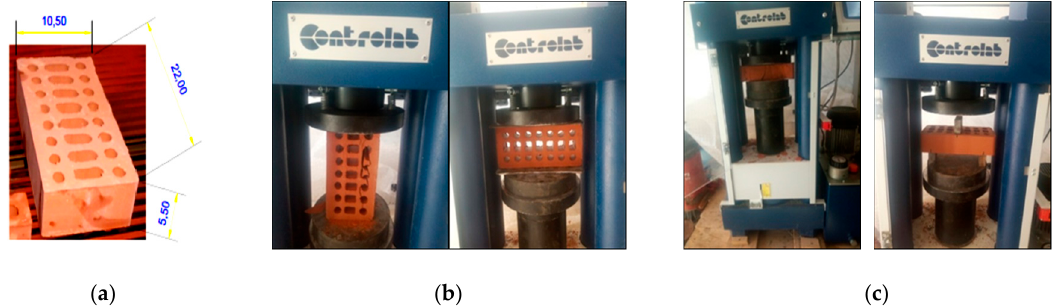
Figure 1. ( a ) Brick units; ( b ) compression test; ( c ) bending test on the brick. Table 1. Compressive strength (fc) and Young’s modulus (E) of mortars and bricks. Material fc (MPa)